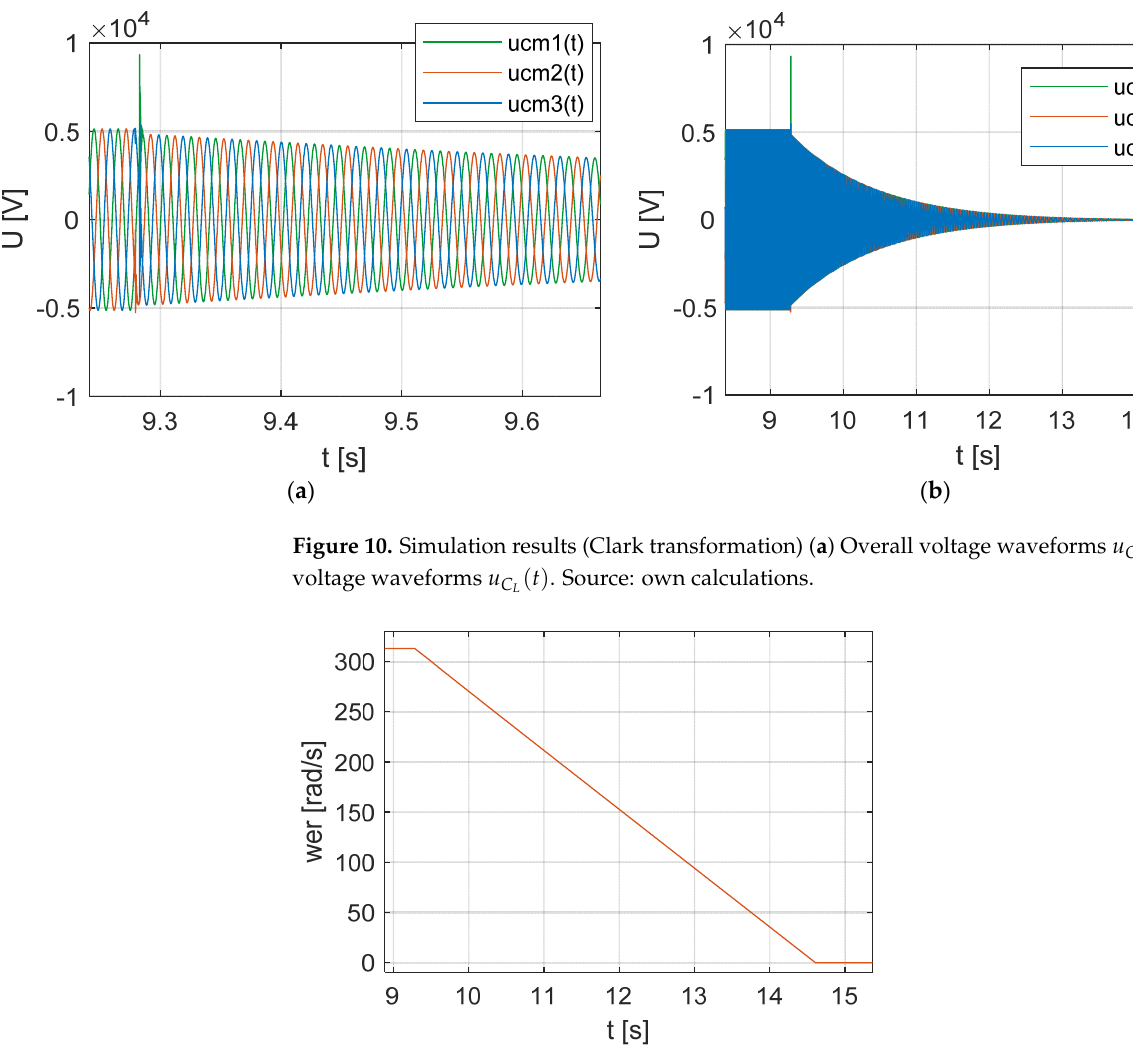
Figure 11. Motor’s angular velocity in electrical degrees. Source: own calculations.